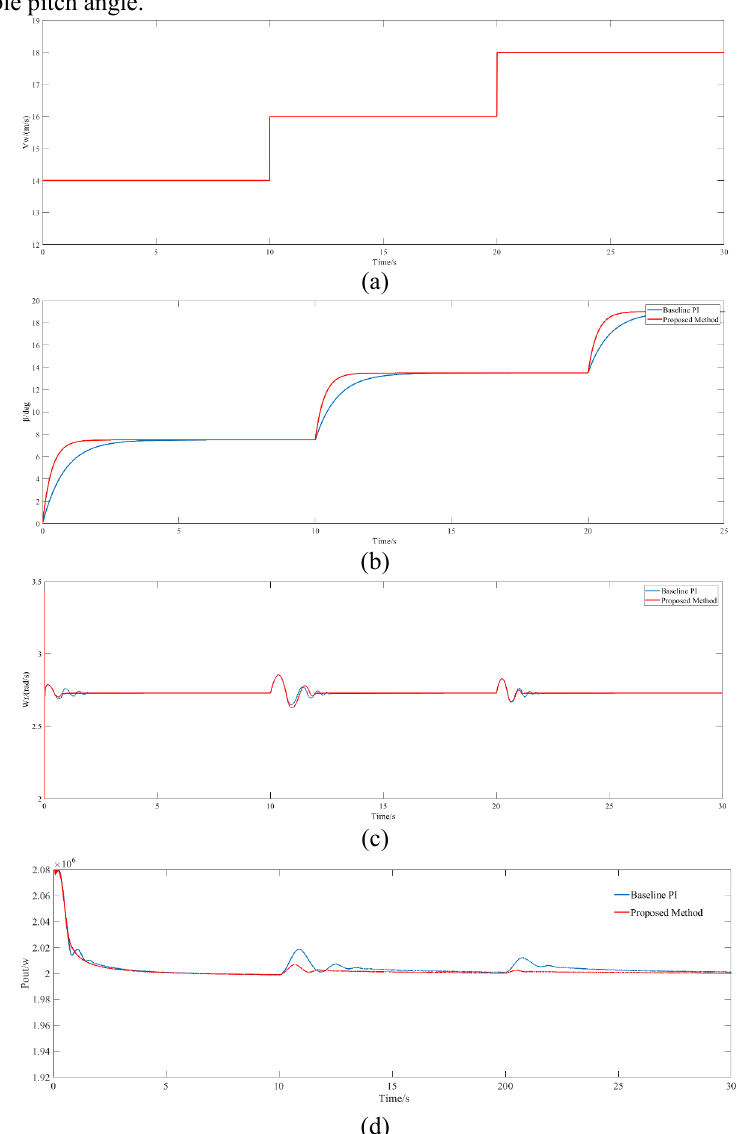
Fig. 4. Simulation